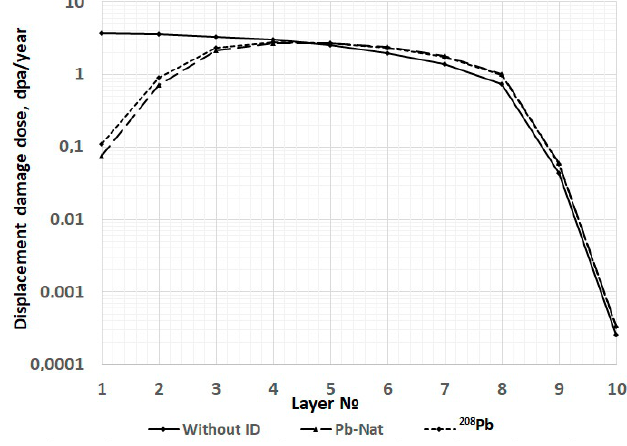
Figure 10. Displacement damage dose for metal structure of the reactor layers. Layer 10 corresponds to reactor vessel. Water gap thickness (layer 9) was 30 cm.